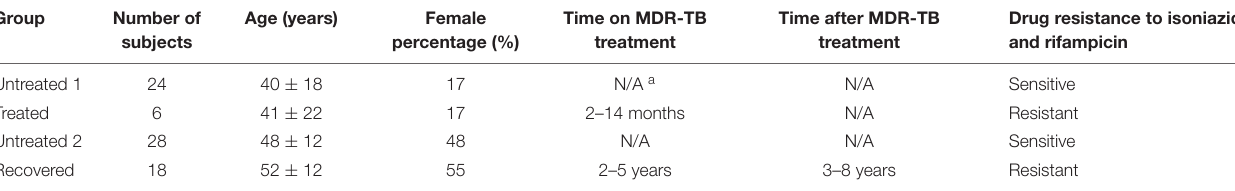
TABLE 1 | Demographic characteristics of the participants ( n =